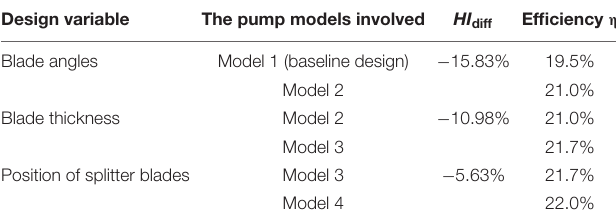
TABLE 6 | Summary of design